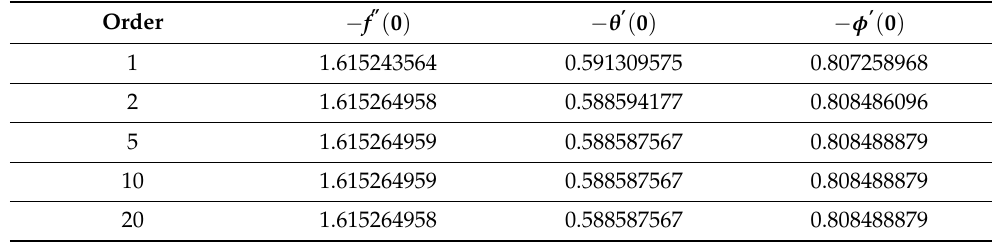
Table 1. Convergence of SLM solution when M = m = 0.5, V = 2.0, Nb = 0.3, Nt = 0.2, R = Q = 0.1, Pr = Le = 1.0, γ = 0.2, Ω = 0.1.